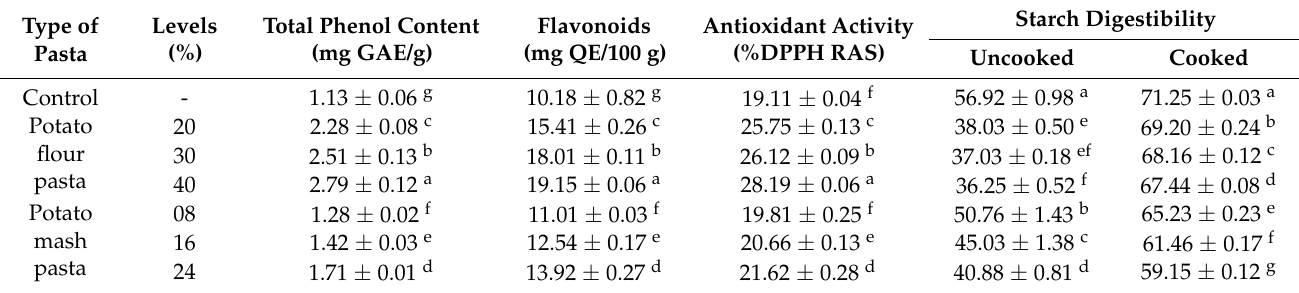
Table 4. Bioactive constituents, antioxidant activity, and in vitro starch digestibility of potato powder and mash